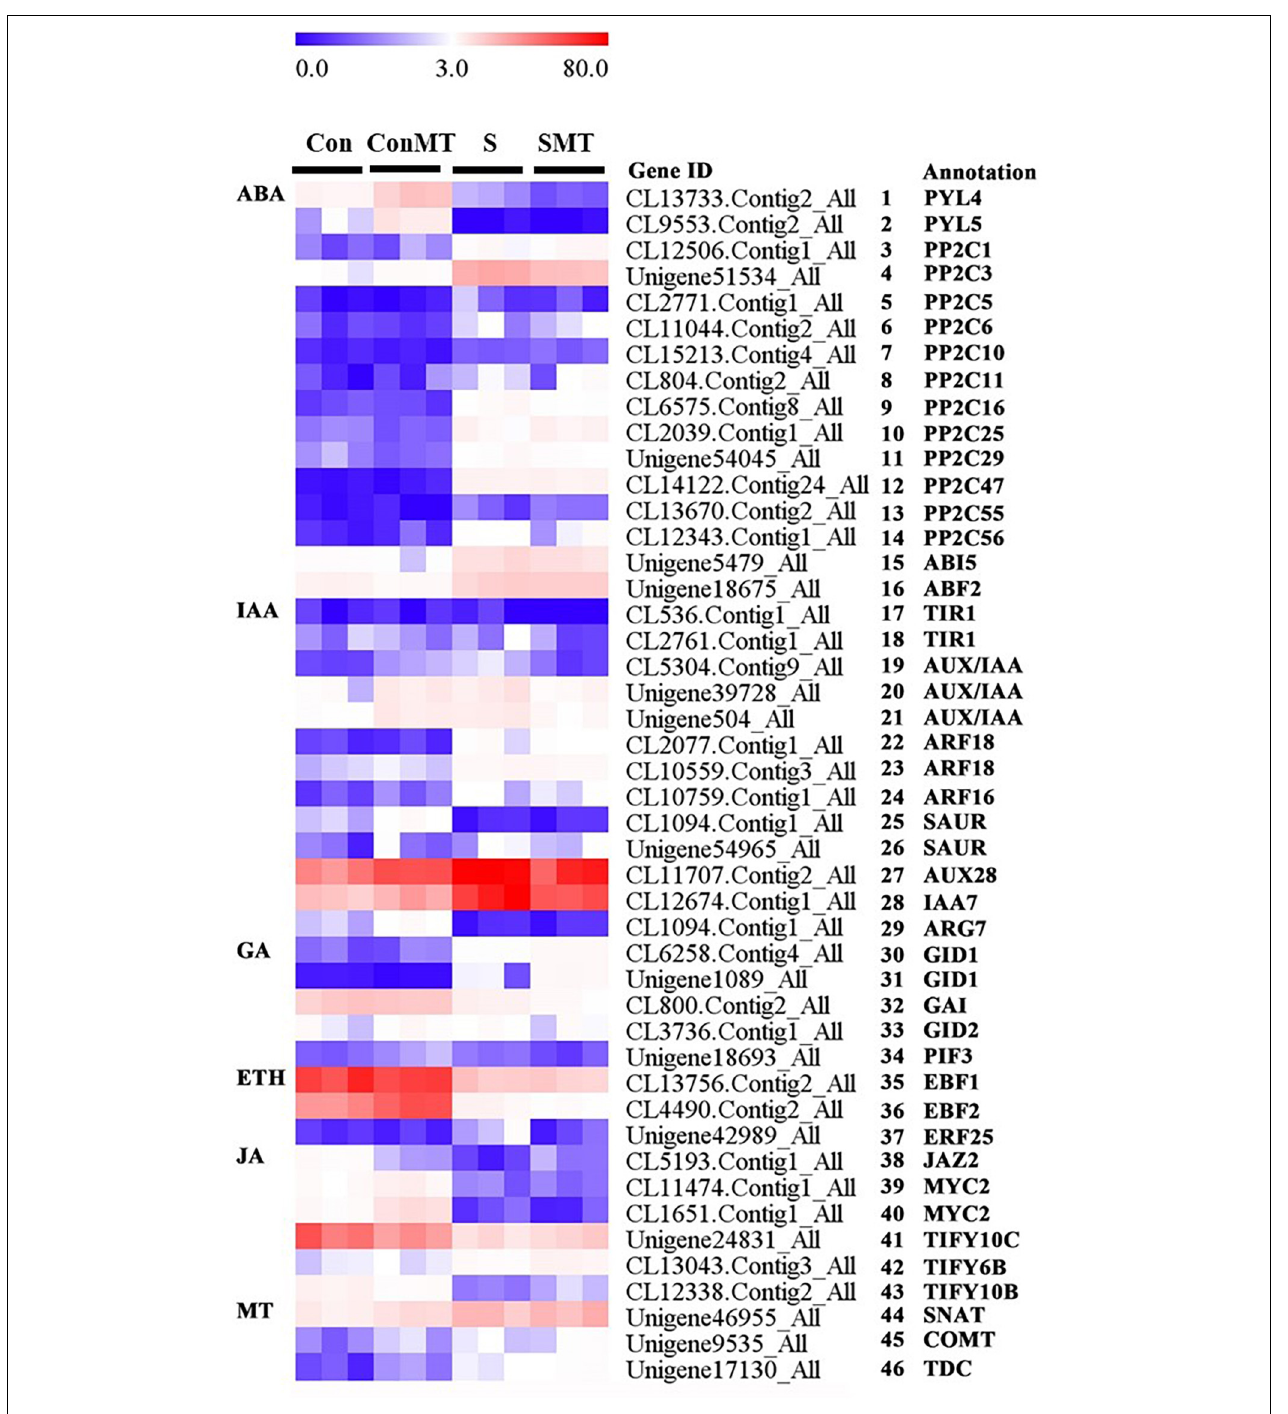
FIGURE 7 | Differentially expressed genes related to plant hormone under heat stress. The bar represents the expression (FPKM) of each gene in Con, ConMT, S, SMT, as indicated by blue, white, and red squares. Blue and red represent low and high expression, respectively. Con, control; S, heat stress; SMT, heat stress with exogenous melatonin treatment; ConMT, control with exogenous melatonin treatment. More detailed information is provided in Supplementary Table 13 .